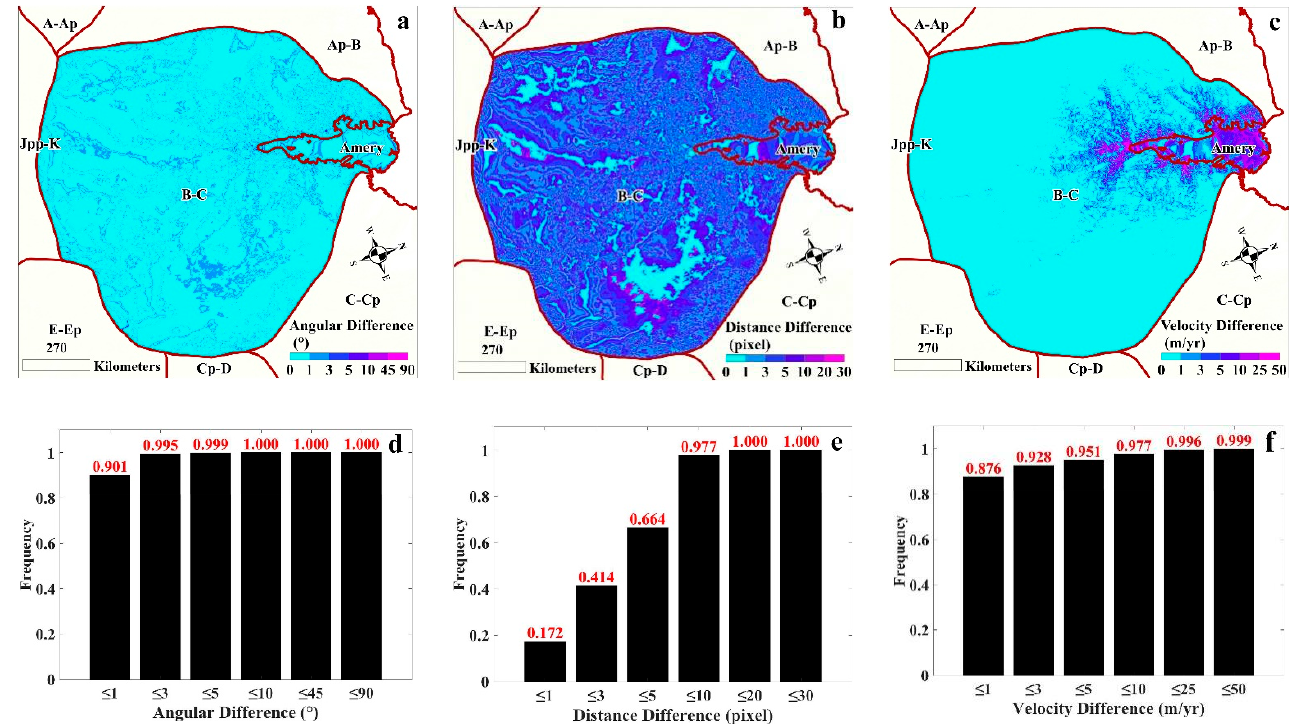
Figure 5. Spatial distribution of angular, distance, and velocity differences of pointing pixels in the B-C basin and its fringing Amery ice shelf as well as the corresponding cumulative frequency distribution histograms. ( a ) Spatial distribution of angular difference. ( b ) Spatial distribution of distance difference. ( c ) Spatial distribution of velocity difference. ( d ) Cumulative frequency distribution histogram of angular difference. ( e ) Cumulative frequency distribution histogram of distance difference. ( f ) Cumulative frequency distribution histogram of ice flow velocity difference.